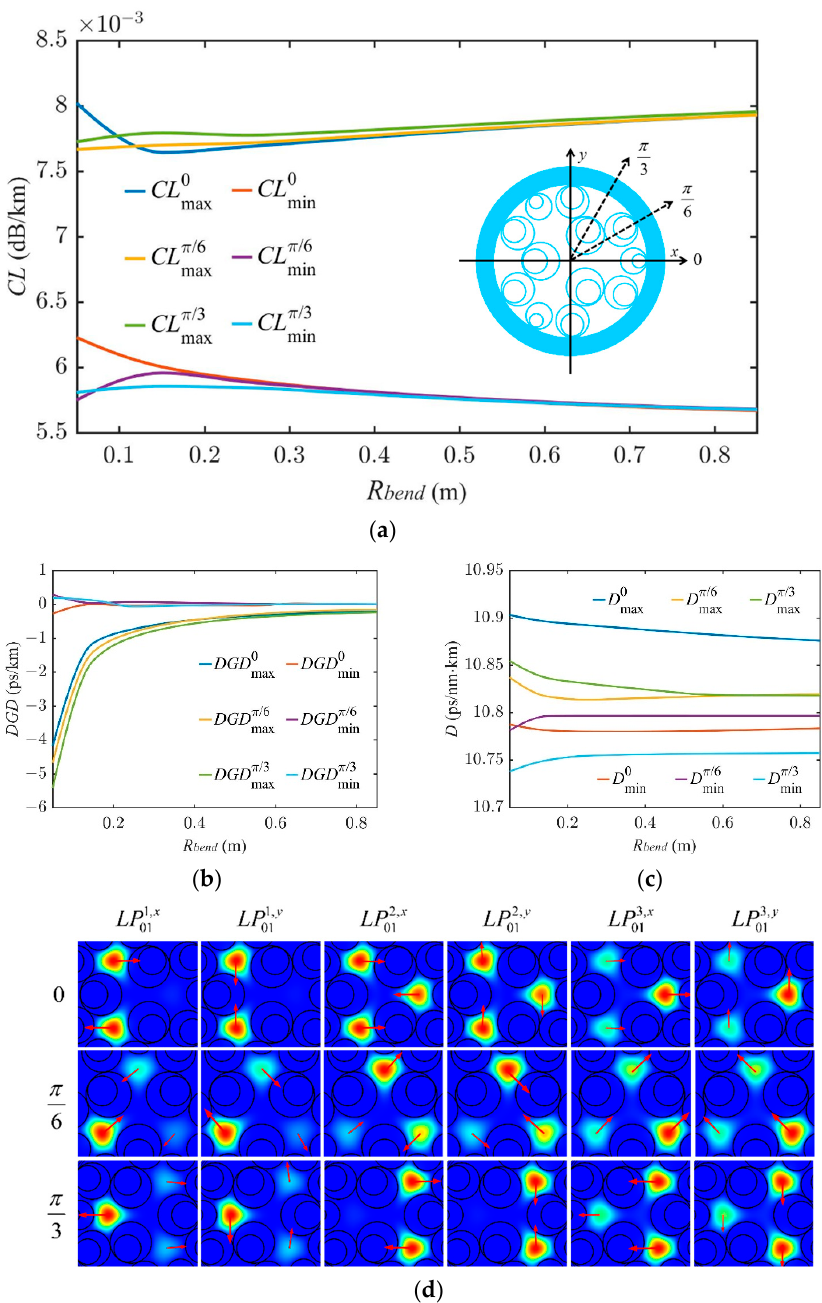
Figure 11. ( a ) Change in CL with the bending radius; ( b ) Change in DGD with the bending radius; ( c ) Change in D with the bending radius; ( d ) Electric field distribution of six fundamental supermodes when the bending radius is 0.05 m at three angle conditions (0, π /6, and π /3), the direction of red arrows represents the direction of the electric field.